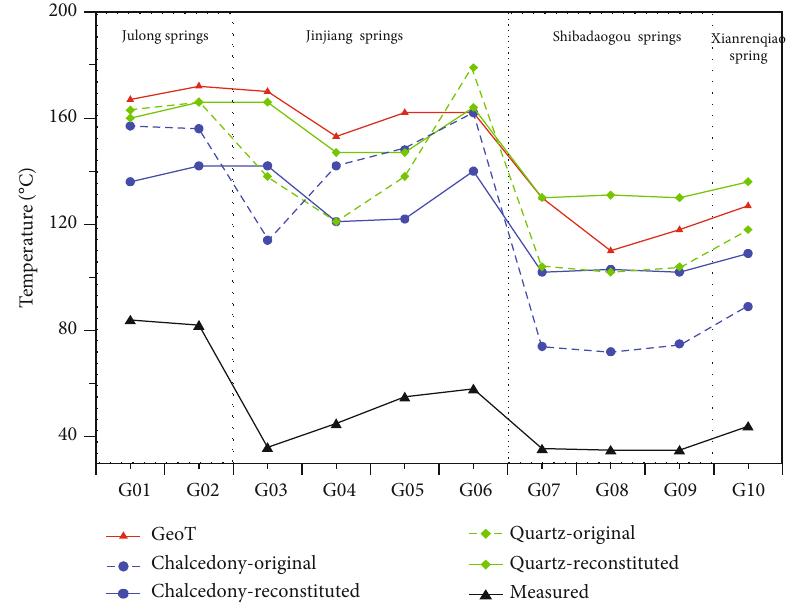
Figure 6: Comparison of temperatures obtained from the integrated multicomponent geothermometry method with those calculated by classic geothermometers.